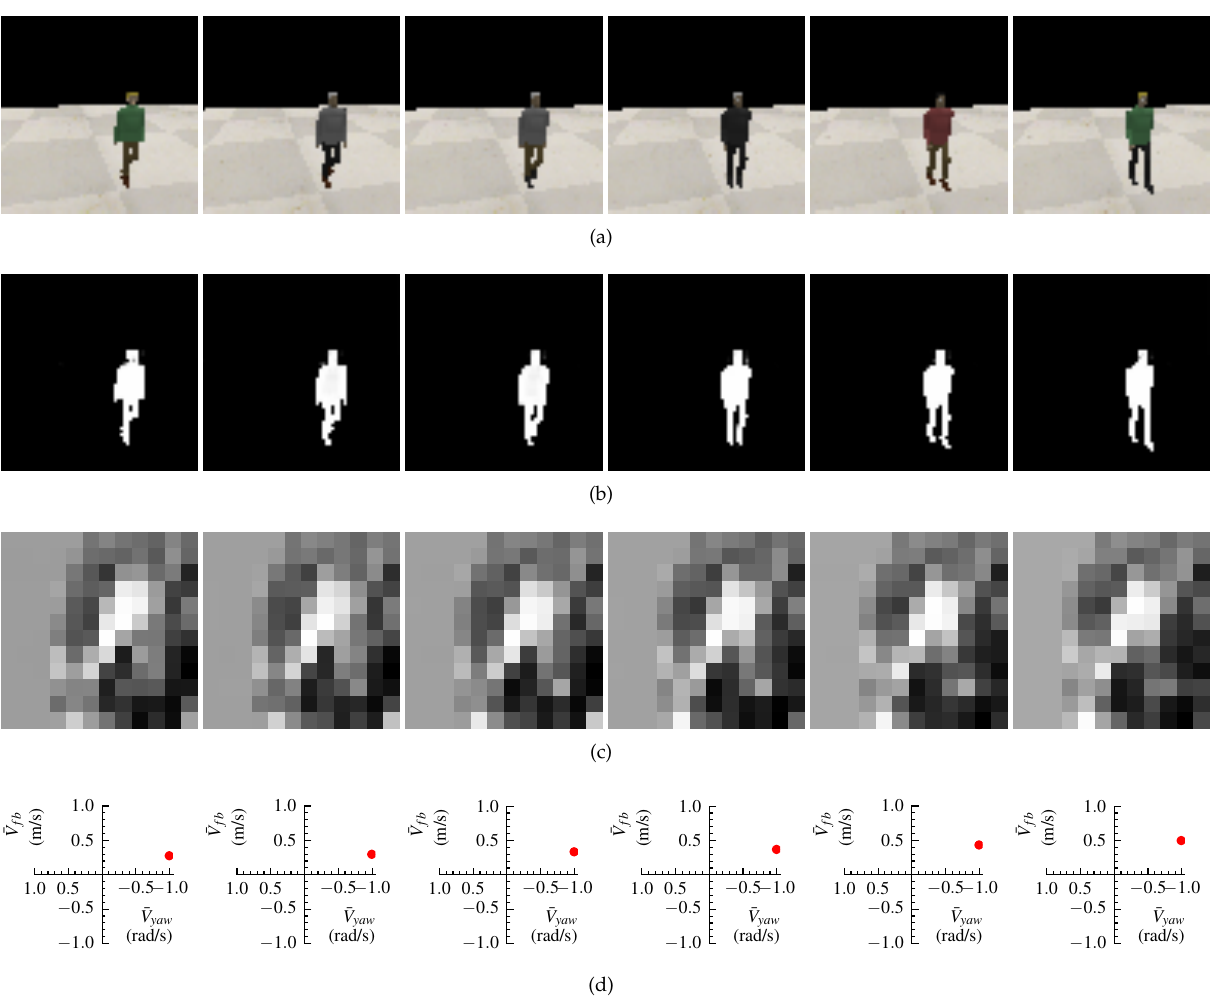
Figure 12. Visualization of layers and output commands in the RL controller given a sequence of raw observations from timesteps t = 720 to t = 725. ( a ) Sequence of raw observation: O 720 to O 725 . ( b ) The corresponding output of the position perception layer: Z 720 to Z 725 . ( c ) The corresponding output of the velocity perception layer: W 720 to W 725 . ( d ) The final commands of the RL controller ¯ V fb , ¯ V yaw .